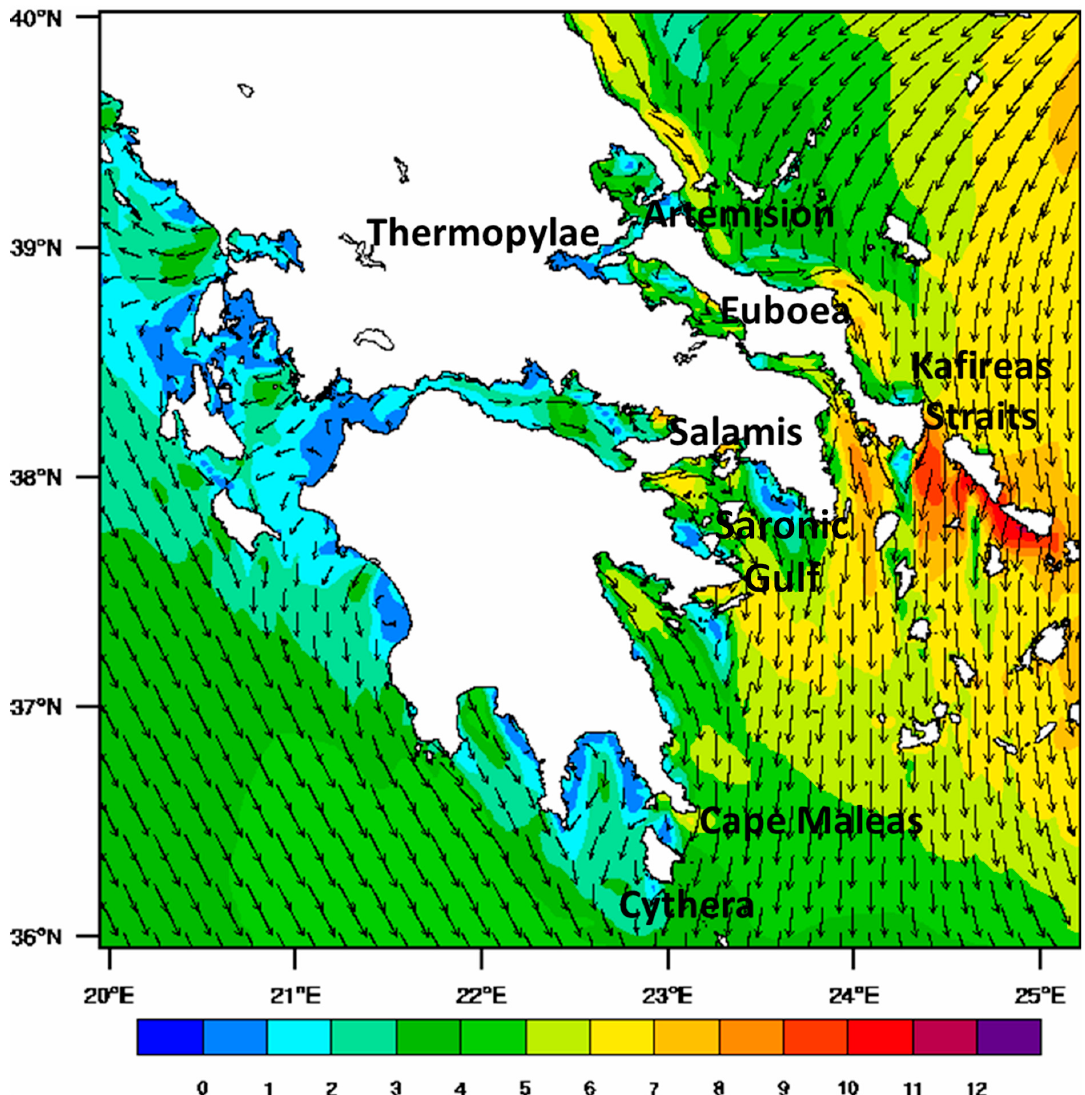
Figure 5. Wind speed in m s − 1 (color scale) and direction (vectors), at 10-m height, 08:00 local standard time (LST). Ten-year average (2007–2016), from WRF intermediate grid at 3×3 km grid space driven by the ERA5 monthly average fields for September.